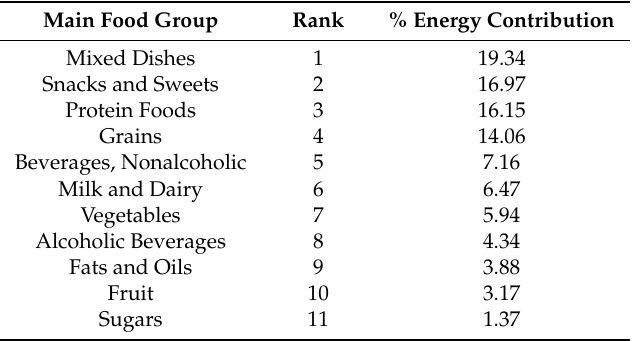
Table 1. Main food group sources of energy (kcal) contribution in the total U.S. diet, adults ≥ 51 years old ( n = 4522; gender combined; daily intake data; National Health and Nutrition Examination Survey. (NHANES) 2011–2014; main food groups contributing <1.0% not reported; data are Day 1 intakes).